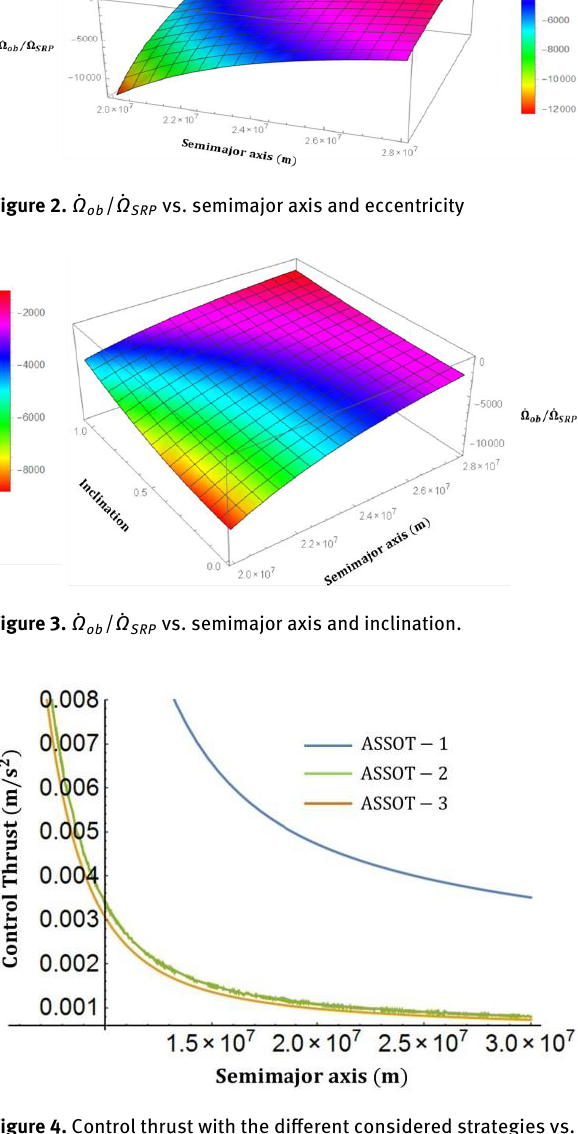
Figure 4. Control thrust with the different considered strategies vs. semimajor